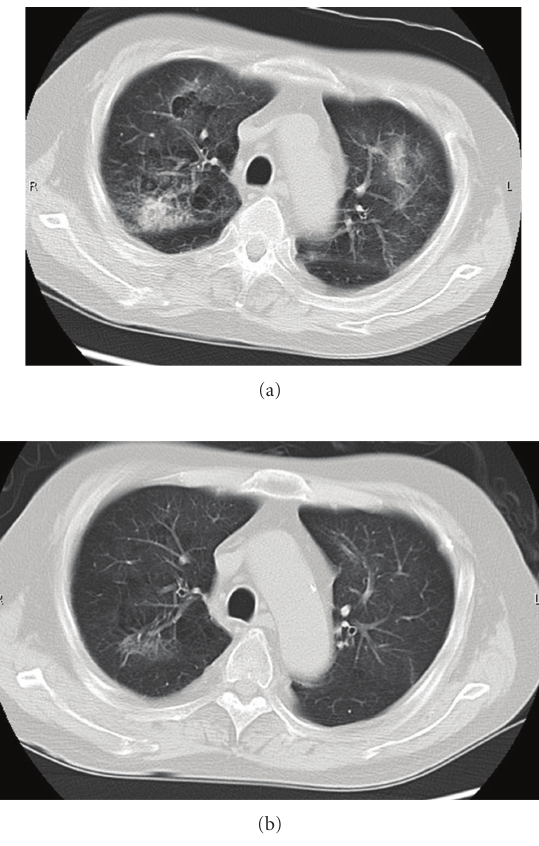
Figure 4: (a) Computed tomography scans on the day patient diagnosed as PCP showed infiltrates and reticular shadows. (b) The shadows disappeared after treatment with antifungal